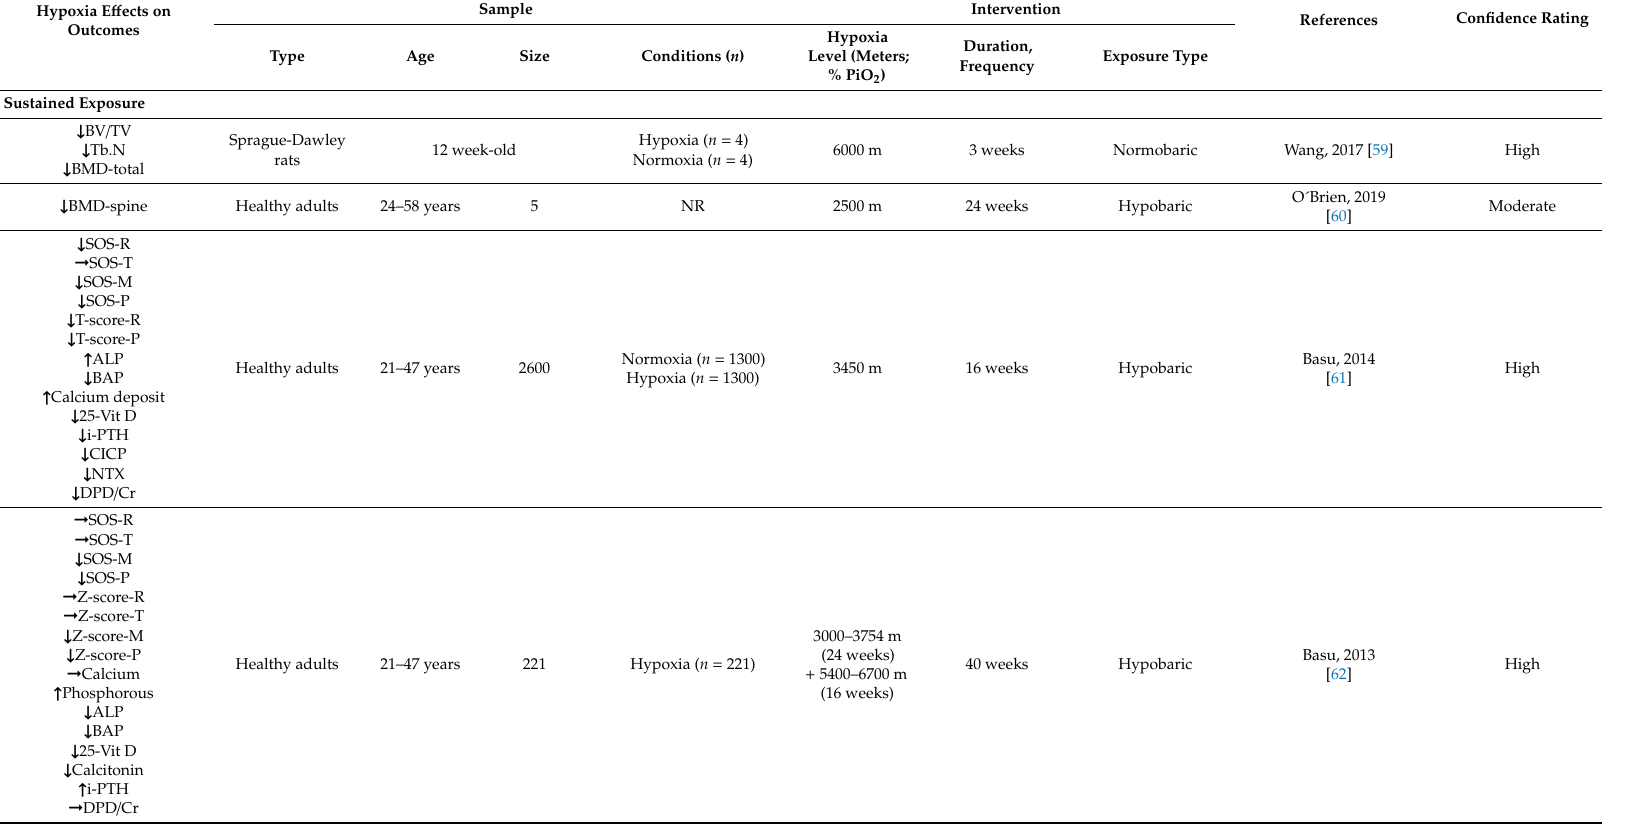
Table 2. Experimental details of in vivo studies included in this